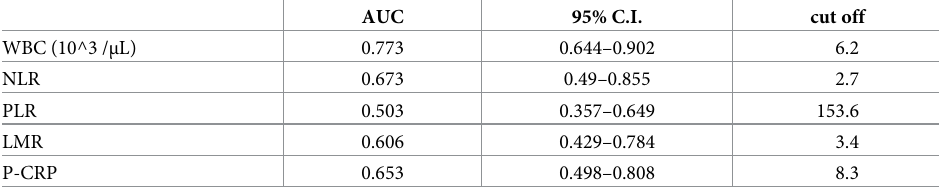
Table 3. AUC and cut-off values for clinical predictors of AL. AUC 95% C.I. cut off WBC (10^3 / μ L) 0.773 0.644–0.902 6.2 NLR 0.673 0.49–0.855 2.7 PLR 0.503 0.357–0.649 153.6 LMR 0.606 0.429–0.784 3.4 P-CRP 0.653 0.498–0.808 8.3 area under the curve; AUC, anastomotic leak; AL, confidence interval; CI white blood cell; WBC, neutrophil- lymphocyte ratio; NLR, platelet-lymphocyte ratio; PLR, lymphocyte-monocyte ratio; LMR platelet count × C-reactive protein level multiplier value;